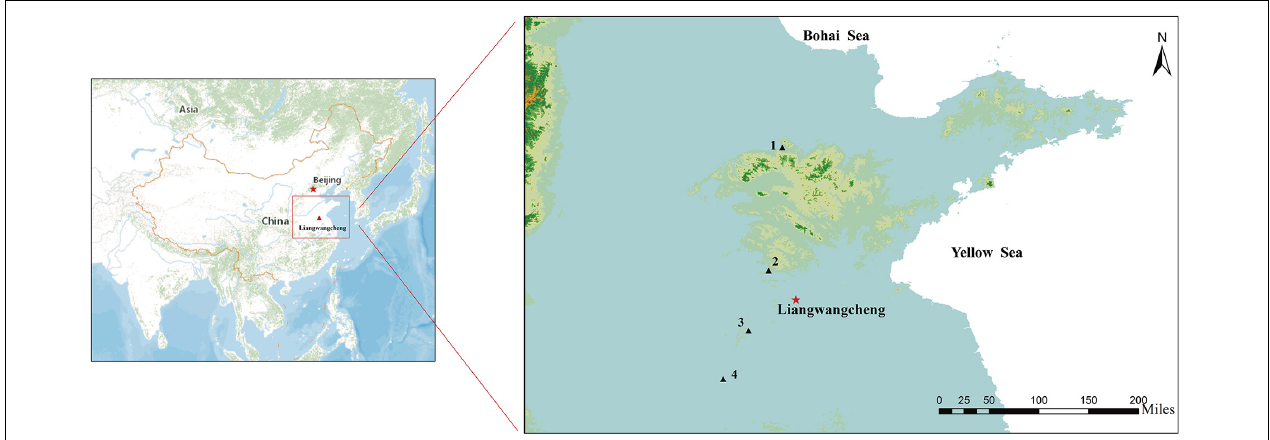
FIGURE 1 | Geographic location of Liangwangcheng and other Dawenkou Culture sites mentioned in this paper. ( 1 , Jiaojia site; 2 , Jianxin site; 3 , Yangpu site; and 4 , Yuchisi site).